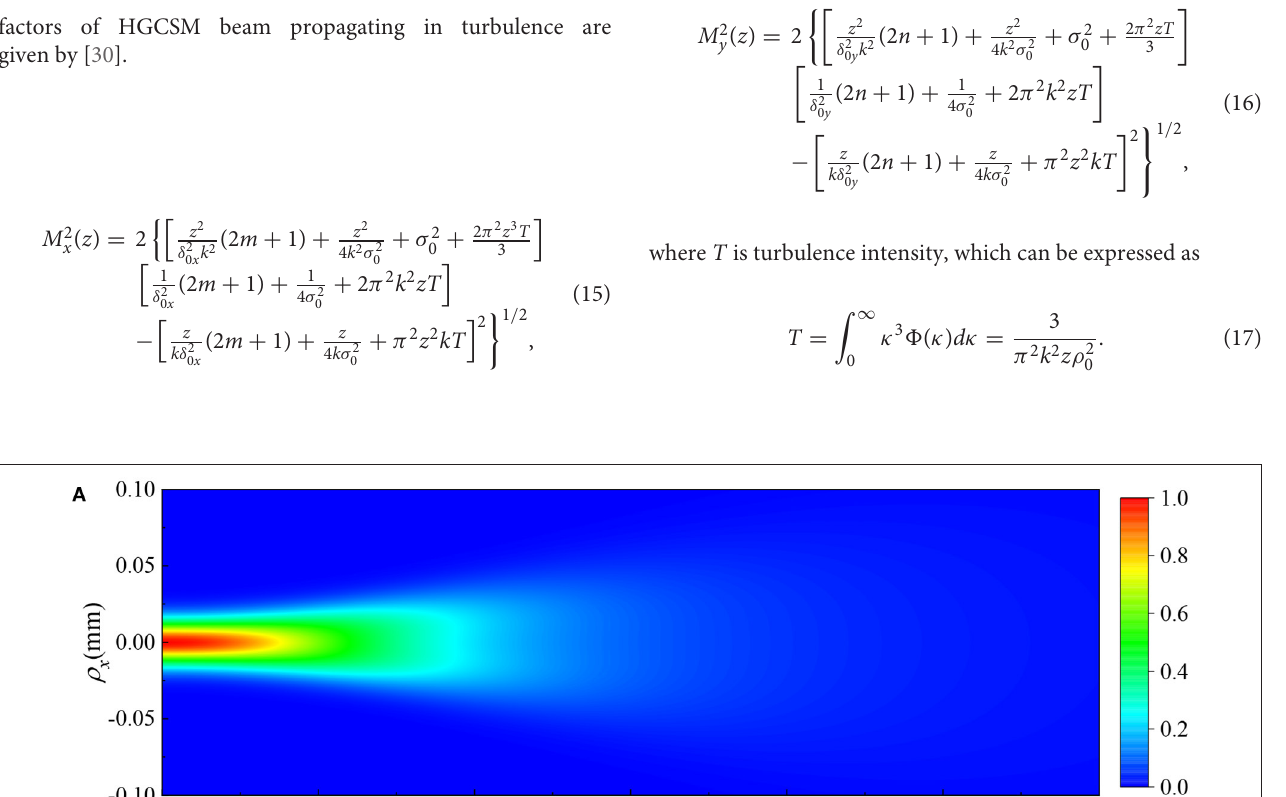
5 and n 0 propagating in turbulent biological tissue (A) in the ρ x = =